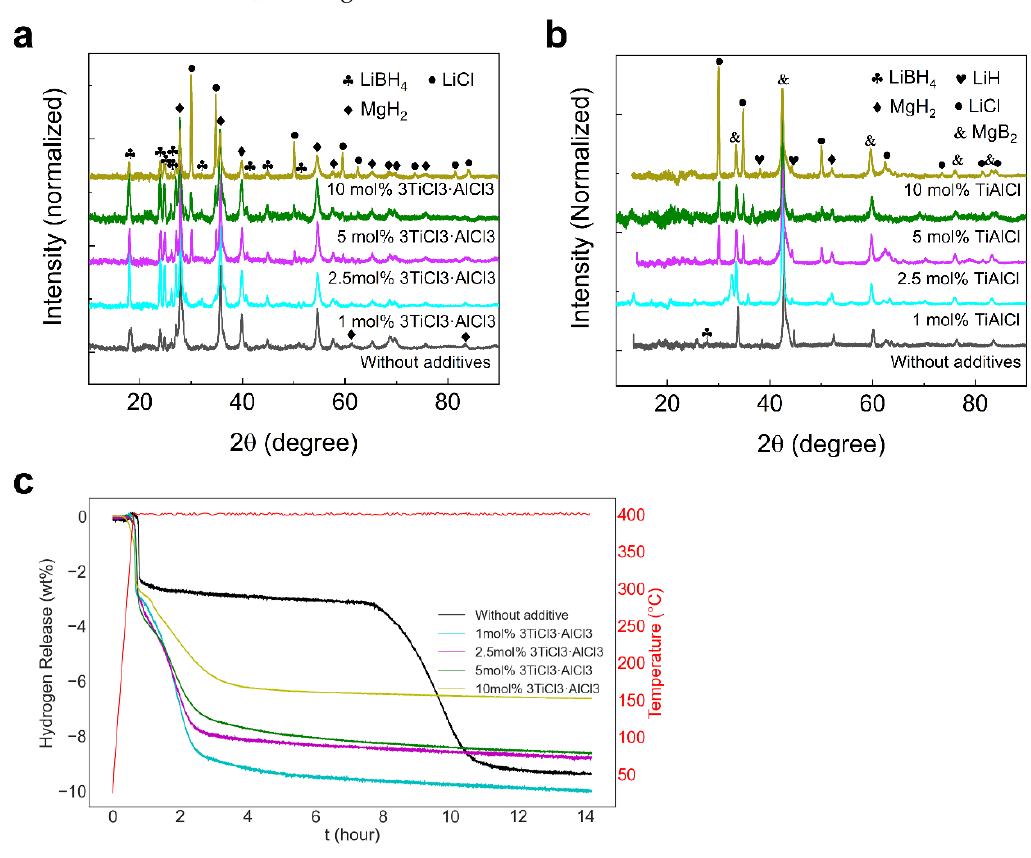
Figure 1. ( a ) XRD patterns of as-milled 2LiBH 4 – MgH 2 with x mol% 3TiCl 3 ·AlCl 3 (x = 0, 1, 2.5, 5